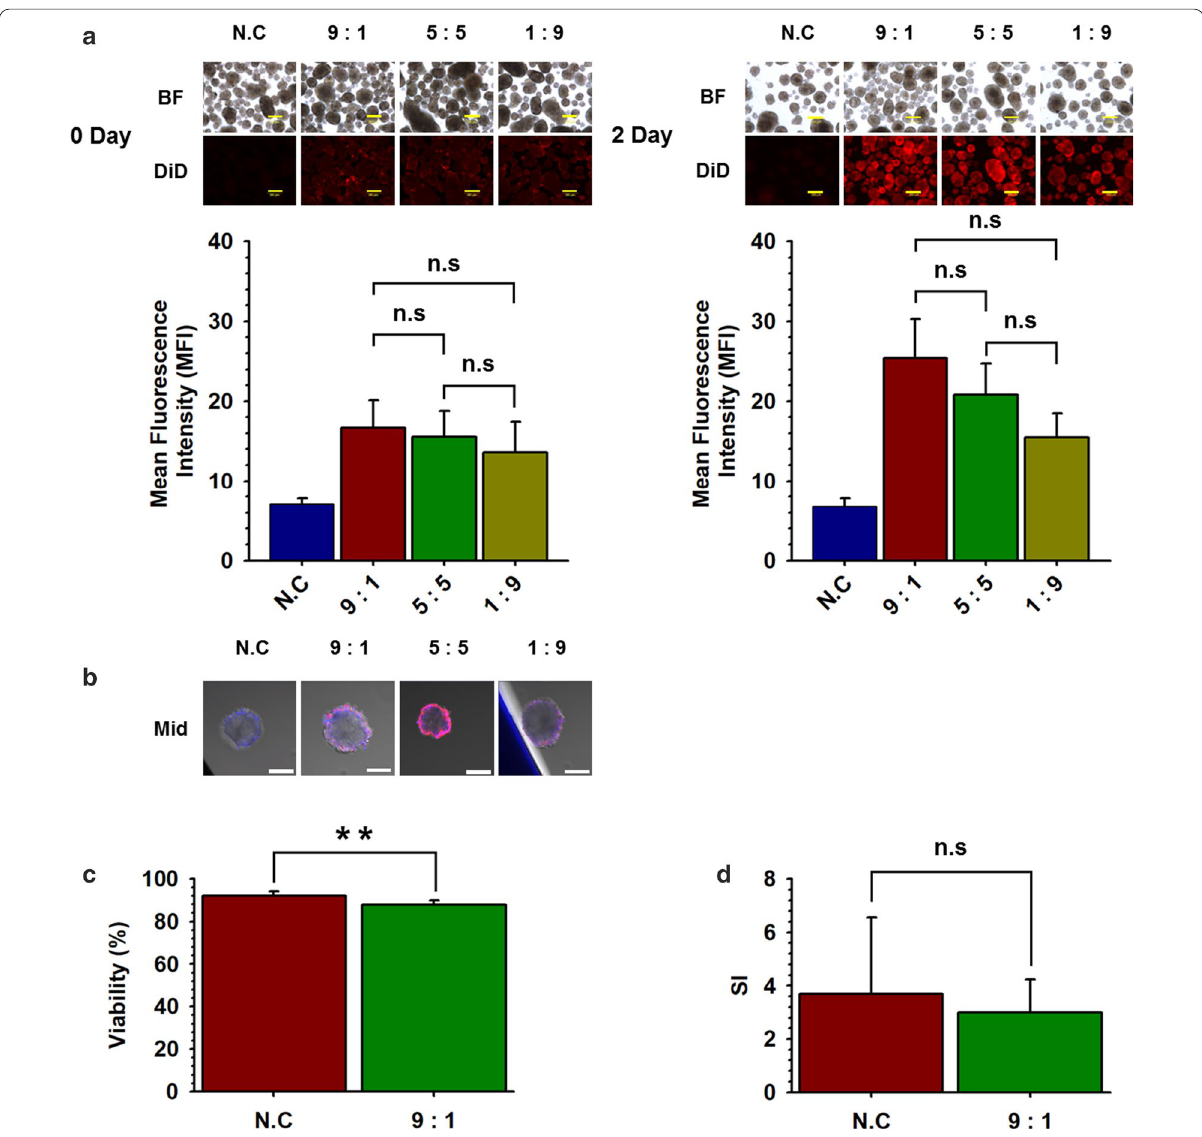
Fig. 5 Coating efficiency and functionality of NHS‑/NH 2 ‑PSome nano‑encapsulated NPCCs. a DiD conjugated 9:1, 5:5, 1:9 of NHS‑/NH 2 ‑PSome nano‑encapsulated NPCCs (9:1, 5:5, 1:9) (NC; non‑coated NPCCs). MFI shows the intensity of DiD‑conjugated PSome nano‑encapsulated NPCCs ( n 3) and NC control ( n 3). The scale bars = = represent 200 um; b CLSM of DiD‑conjugated NHS‑/NH 2 ‑PSome nano‑encapsulated NPCCs (Mid; middle image using CLSM of DiD‑conjugated NHS‑/NH 2 ‑PSome nano‑encapsulated NPCCs). Blue in Mid represent the cell through DAPI staining. The scale bars represent 100 um; C. Viability of 9:1 ( n 9) and NC control ( n 3). Data represent the mean S.D. ** p < 0.01 versus NC; D. SI of 9:1 ( n 9) and NC control ( n 3). Data represent the = = ± = = mean ±